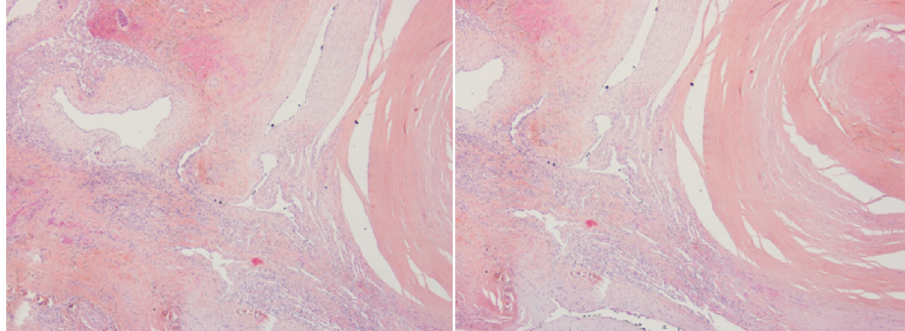
Fig. 3. Distended blood vessel with intravascular fi brous formation. Hematoxylin – eosin staining; color image; enlarged (cid:1)